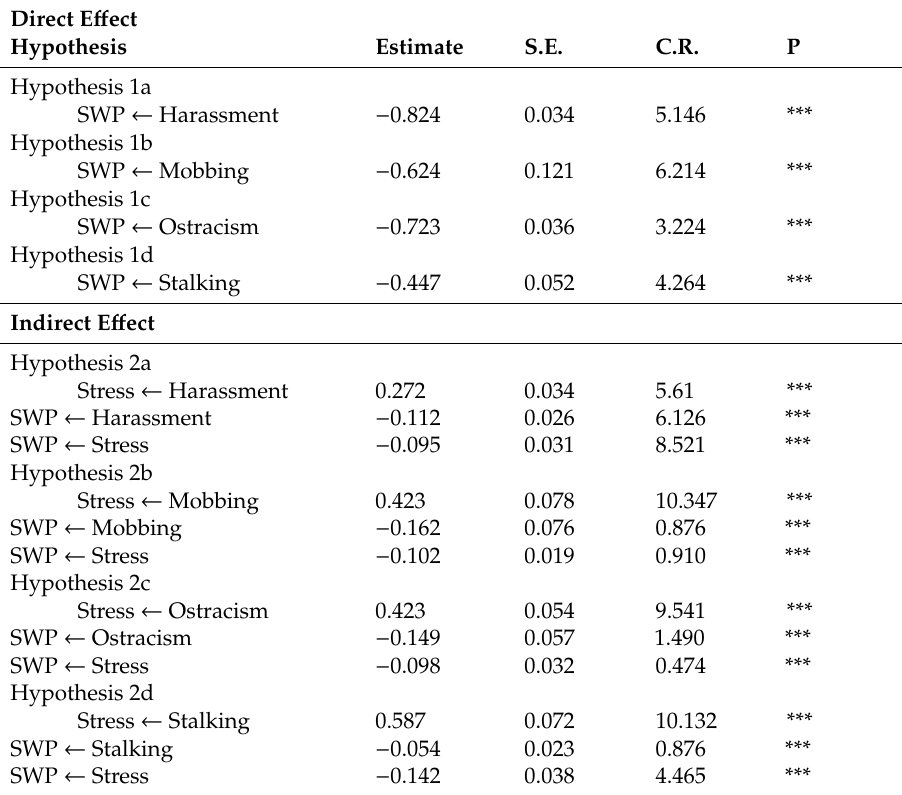
Table 6. Regression